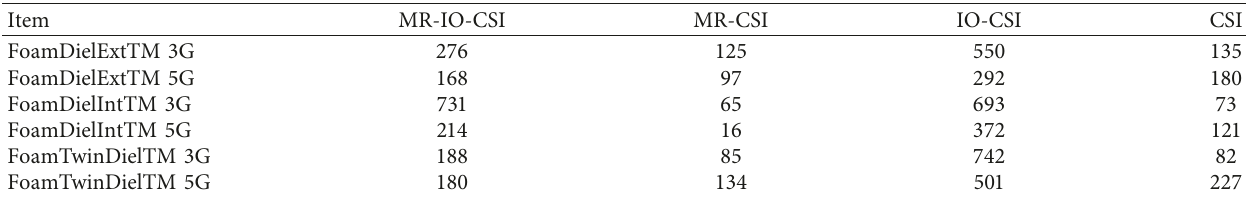
Figure 5: The targets used in the Fresnel experiments (dimension in mm): (a) FoamDielExt, (b) FoamDielInt, and (c) FoamTwinDiel. The small blue circle is plastic cylinder with relative permittivity ε r � 3 ± 0 . 3 and the radius of 15.5mm; the large green circle is foam cylinder with relative permittivity ε r � 1 . 45 ± 0 . 15 and radius of 40mm. Table 1: The iteration times for different